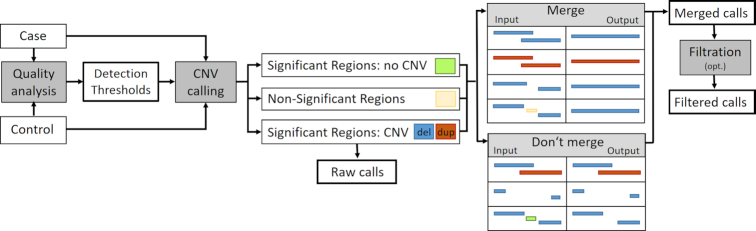
Overview of the analysis performed by CopyDetective. The analysis can be separated into 4 major steps: (i) Quality analysis: the detection thresholds for CNV calling are estimated. (ii) CNV calling: significant regions with and without CNV are determined. (iii) Merging of overlapping and adjacent regions with CNV. (iv) Optional filtration.